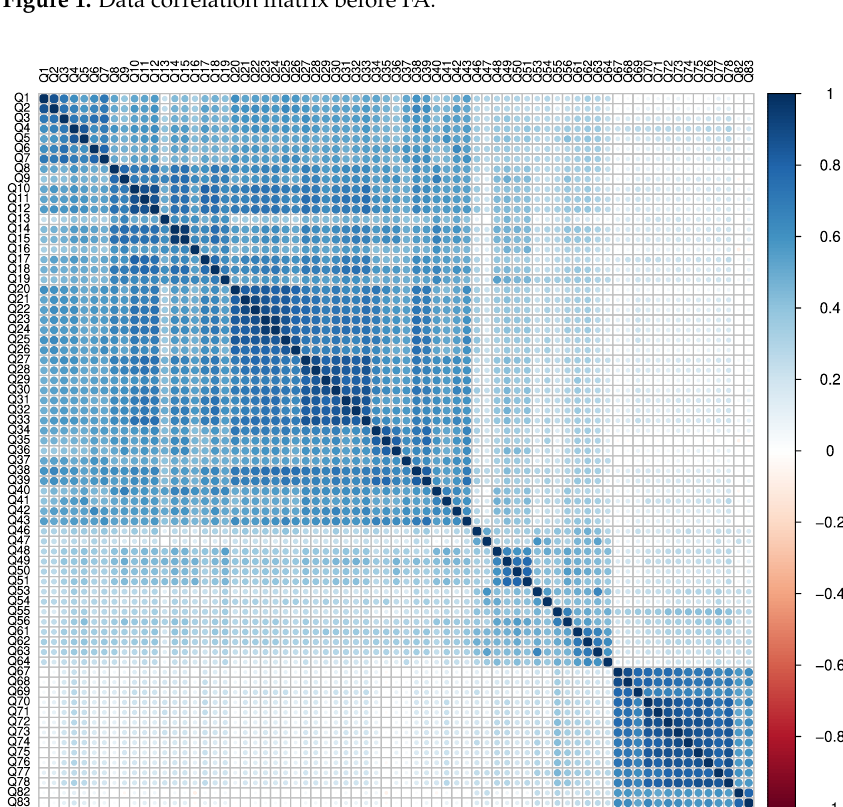
Figure 2. Data correlation matrix after FA. The questions are numbered in accordance with the original questionnaire.